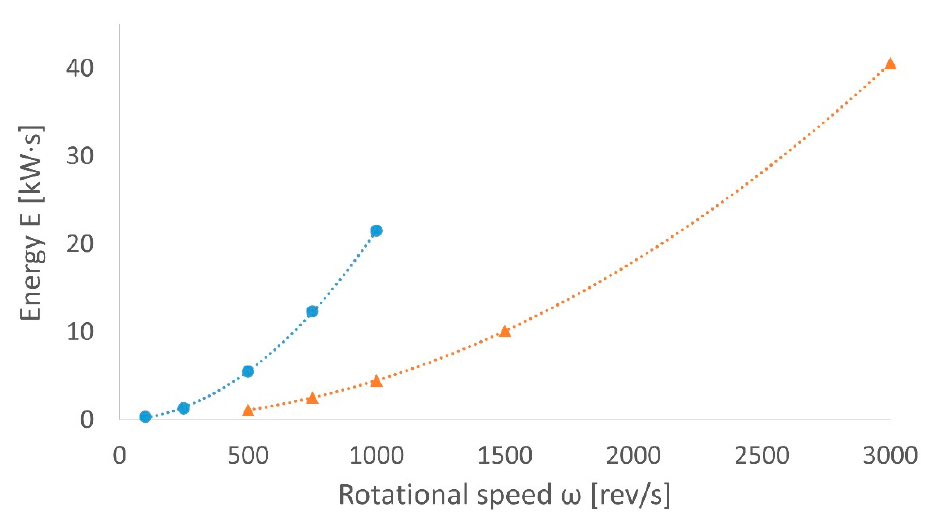
Figure 15. The correlation between the consumed energy in the acceleration phase and the rotational speed ω for a constant maximum rotational acceleration ε for WDU (orange) and perforating head (blue) drives.